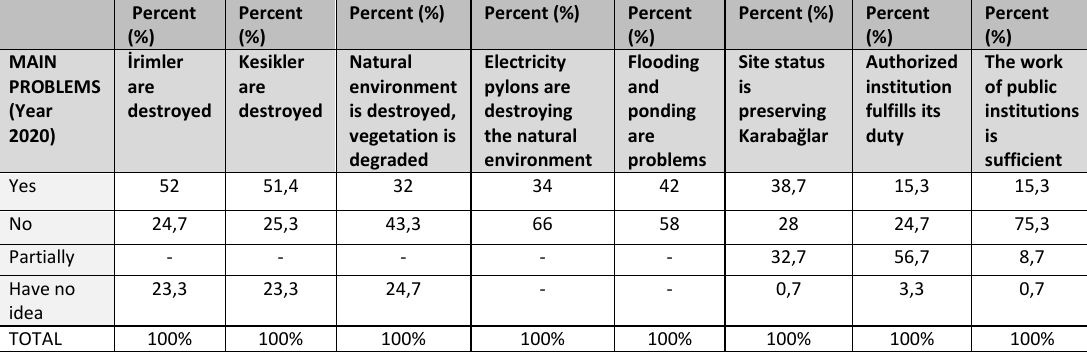
Table 5 Perceptions of the respondents about the main problems in Karabağlar in 2020